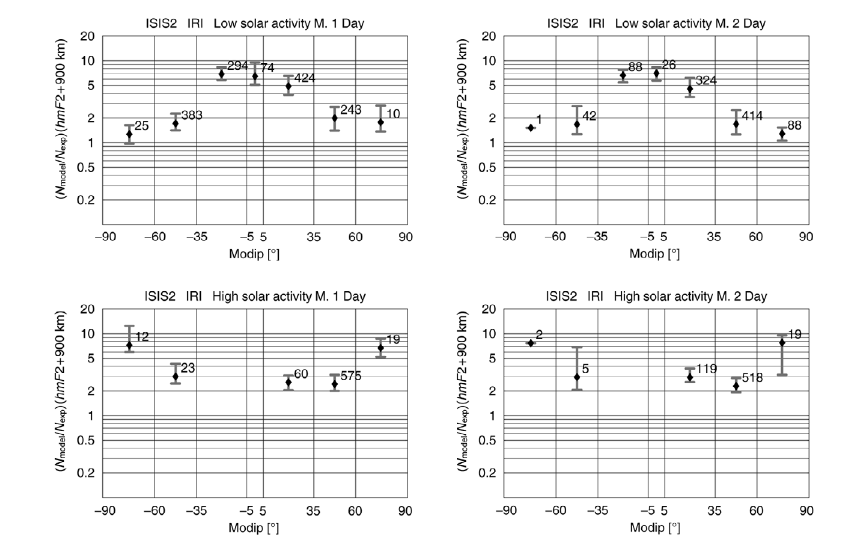
Fig. 6. Comparison of electron density, IRI model, 900 km above hmF 2 for months groups 1 and 2. Numbers indicate the amount of